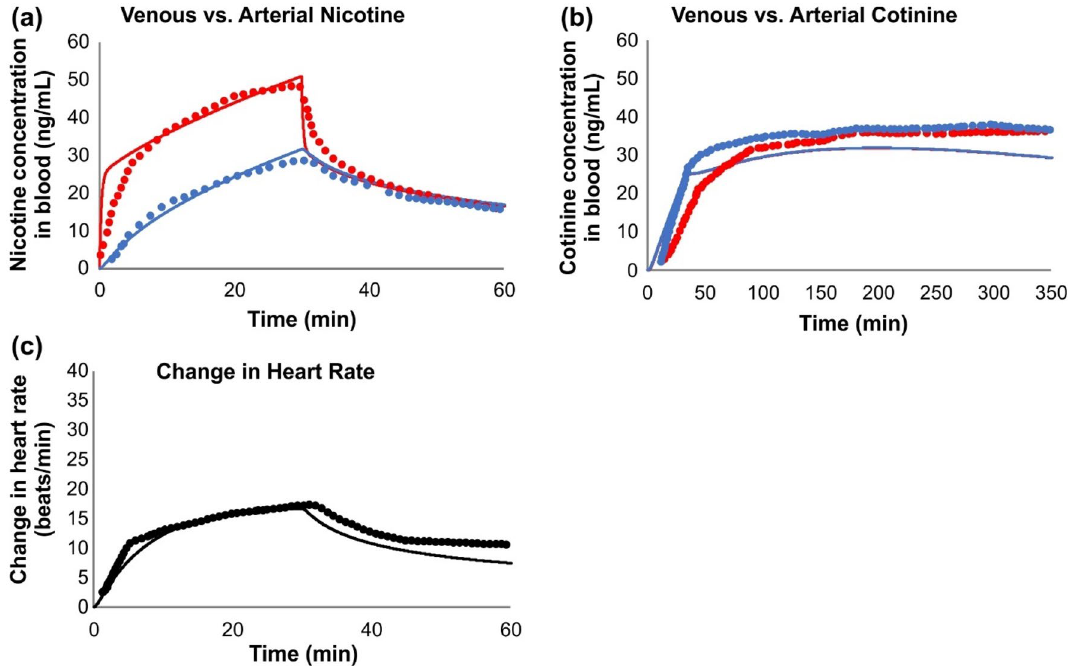
Figure 11. Simulation of the intravenous administration of nicotine in human 26 . Subjects (N = 22) were administered nicotine at a rate of 2 µg/kg/min for 30 min; dotted line represents data from study and solid lines represent simulation results. Red lines and dots correspond to arterial blood and blue lines and dots to venous